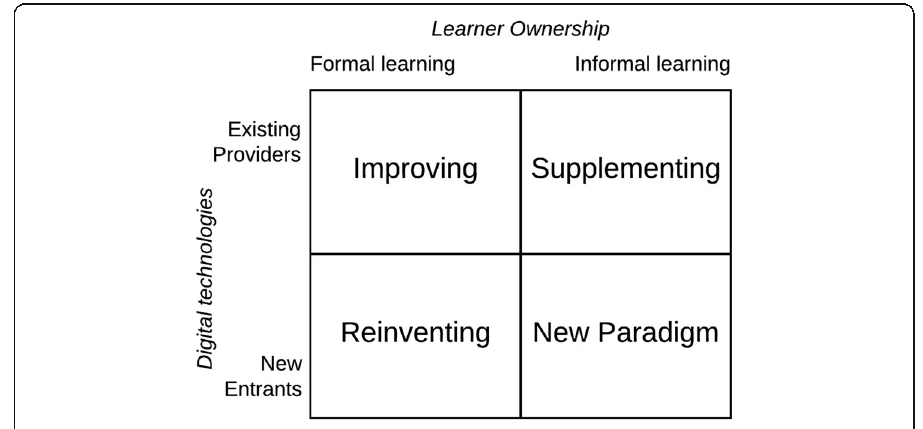
Fig. 1 The education innovation grid (Adapted from Roumen & Kovatcheva,